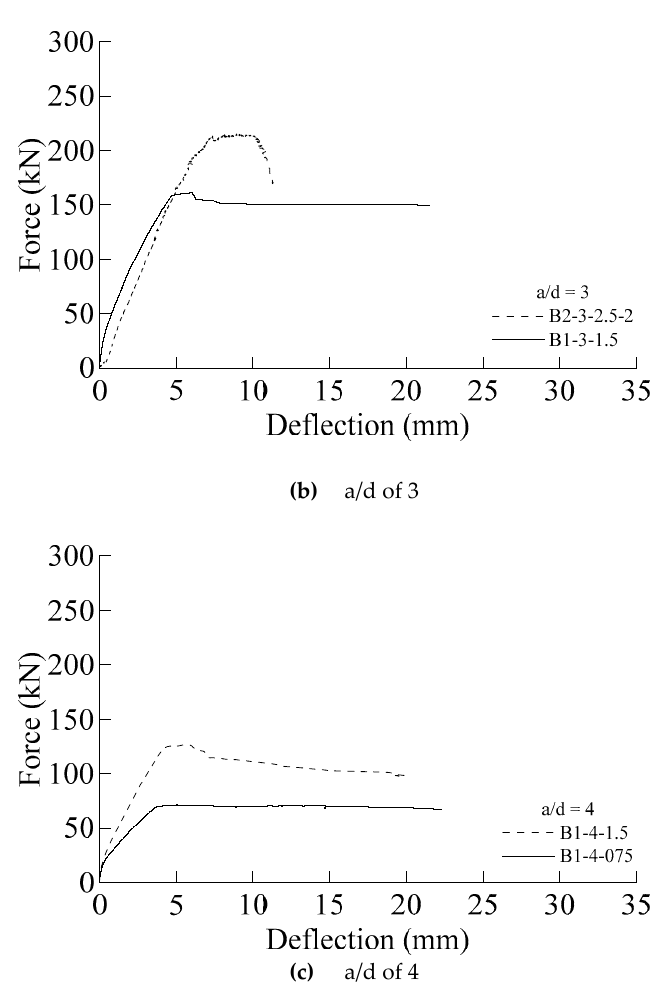
Figure 5. The force-middle span deflection curves for selected specimens.